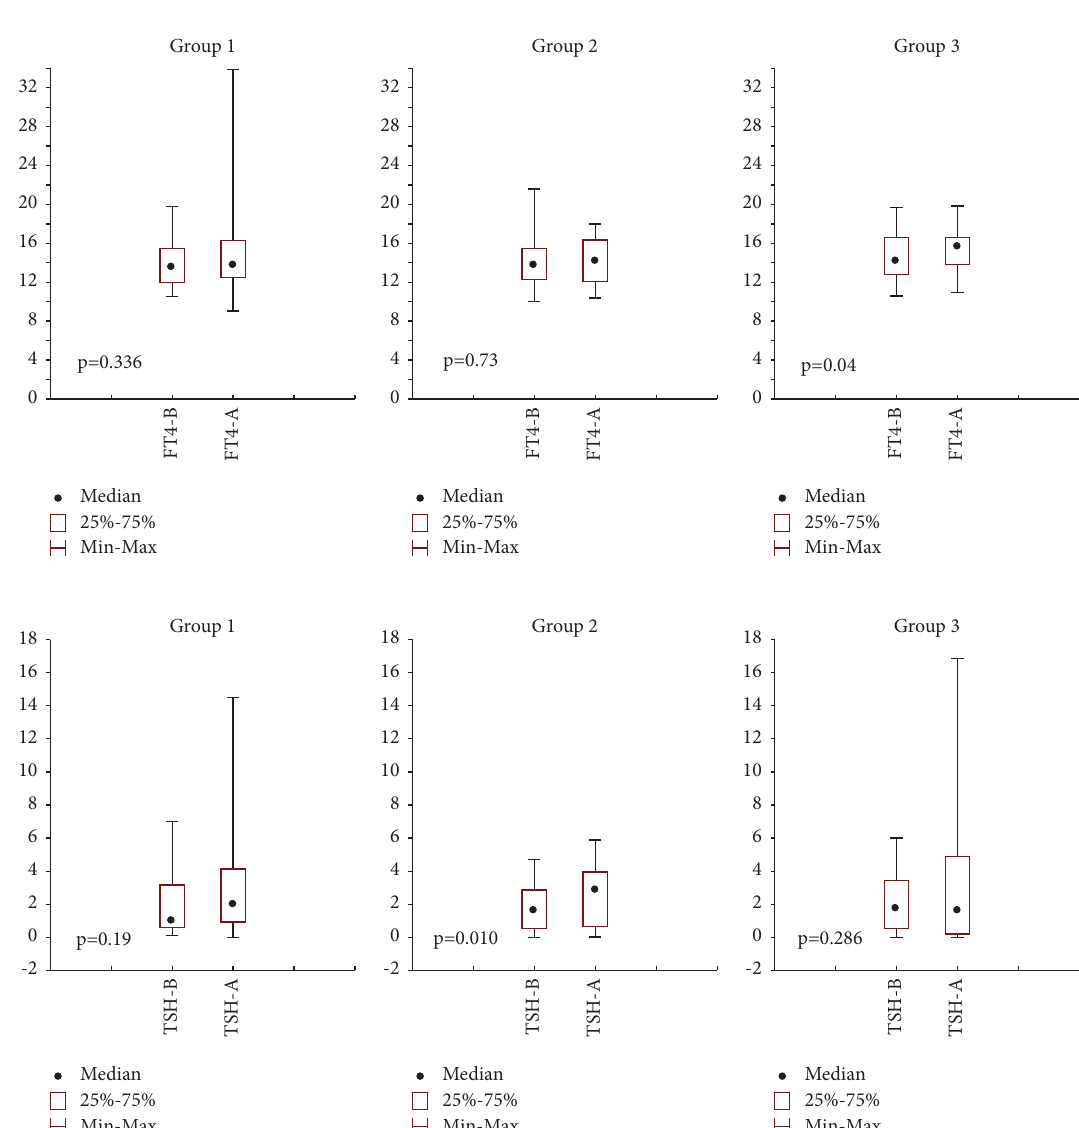
Figure 3: Wilcoxon pairwise test for FT4 and TSH values before (B) and after (A) Ramadan, stratifed by the levothyroxine timing group (group 1: took levothyroxine 30 minutes before iftar; group 2: took levothyroxine 4hours after iftar; group 3: no specifc